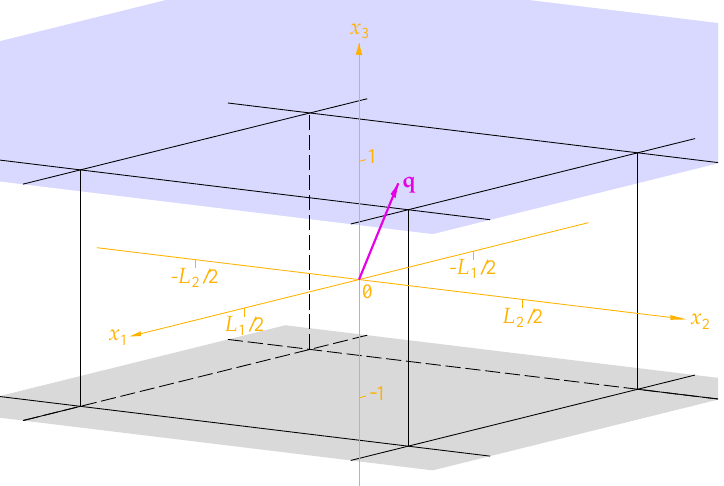
Figure 1. An illustrative sketch of the physical process: there is a dielectric over the upper horizontal boundary (blue) of the fluid layer (white), the lower horizontal boundary (gray) is electrically conducting, and the flow satisfies the no-slip boundary conditions at the boundaries. The fluid layer is rotating about the axis, whose arbitrary direction is shown by the unit vector q (magenta), the Cartesian coordinate system (orange colour, respectively) is co-rotating with the